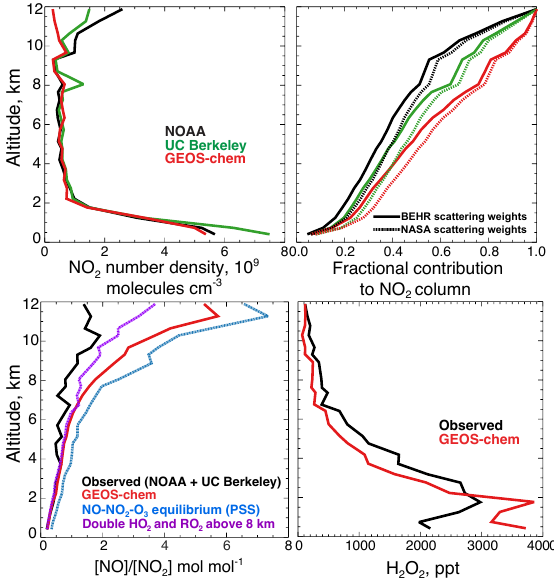
Figure 6. Vertical distribution of NO 2 over the Southeast US dur- ing SEAC 4 RS (August–September 2013) and contributions to tro- pospheric NO 2 columns measured from space by OMI. The top left panel shows median vertical profiles of NO 2 number density mea- sured from the SEAC 4 RS aircraft by the NOAA and UC Berke- ley instruments and simulated by GEOS-Chem. The top right panel shows the fractional contribution of NO 2 below a given altitude to the total tropospheric NO 2 slant column measured by OMI, ac- counting for increasing sensitivity with altitude as determined from the retrieval scattering weights. The bottom left panel shows the median vertical profiles of the daytime [NO] / [NO 2 ] molar con- centration ratio in the aircraft observations (NOAA for NO and UC Berkeley for NO 2 ) and in GEOS-Chem. Also shown is the ratio computed from NO–NO 2 –O 3 photochemical steady state (PSS) as given by Reactions (4) and (6) (blue) and including Reaction (5) with doubled HO 2 and RO 2 concentrations above 8km (purple). The bottom right panel shows the median H 2 O 2 profile from the model and from the SEAC4RS flights over the Southeast US. H 2 O 2 was measured by the Caltech CIMS (see Fig.